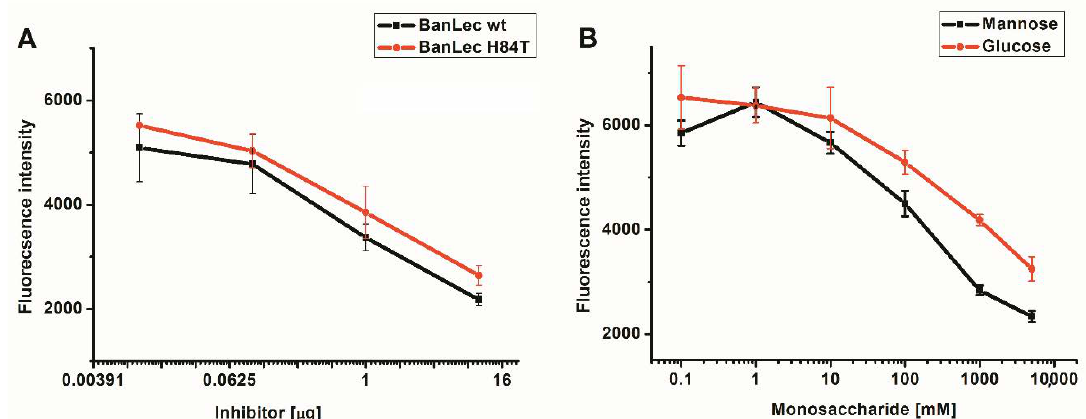
Figure 2. Inhibition of BanLec-eGFP binding to influenza vaccine high-mannose glycans with BanLec wt and BanLec H84T ( A ), and with monosaccharides ( B ), in fluorescence-linked lectin sorbent assay (FLLSA). The experiment was repeated three times in triplicate.